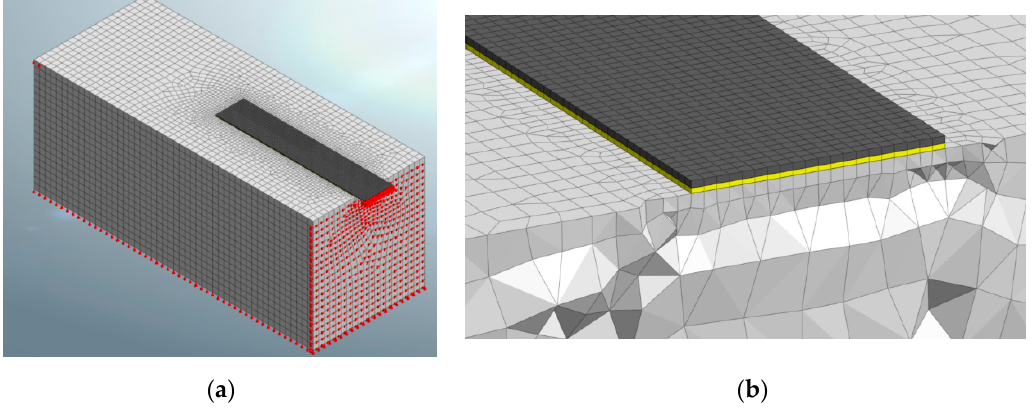
Figure 3. The 3D model: ( a ) global view; ( b ) detail of the elements